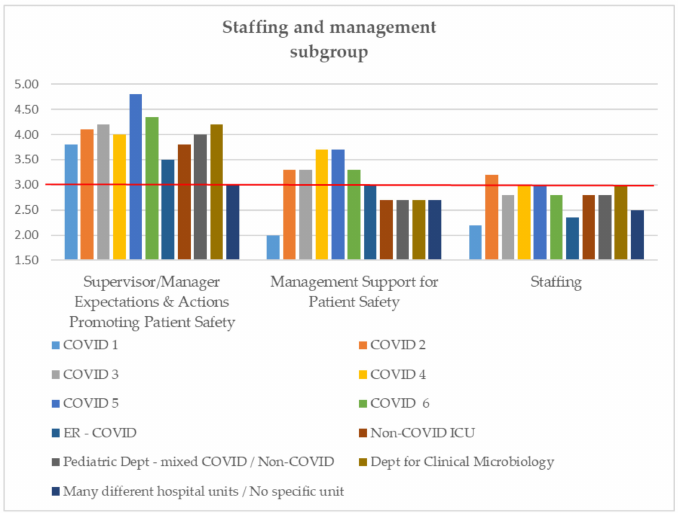
Figure 2. PSC dimension values for the “Staffing and management” group across